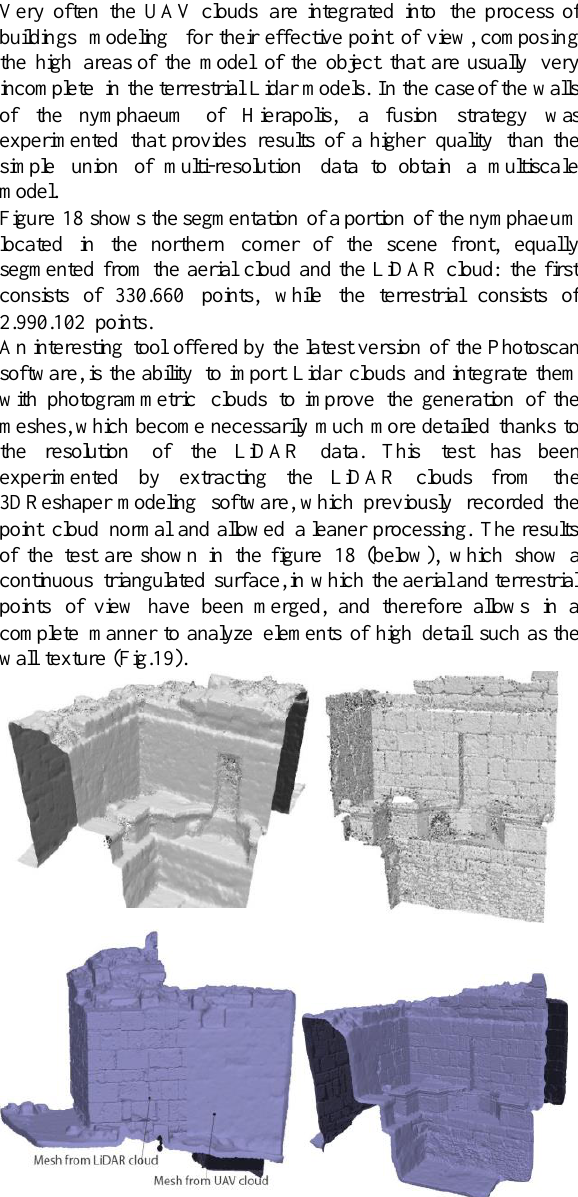
Figure 18. (above) Visual comparison among segmented clouds (UAV: 330.660 p.; LiDAR 2.990.102 p.). (below) comparison among meshes and final mesh from integrated clouds.